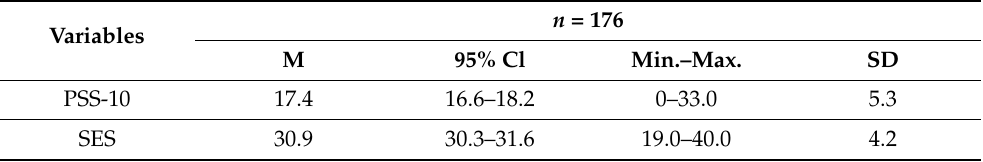
Table 2. Results of descriptive statistics for stress intensity, global self-esteem and sense of coherence in the study group.